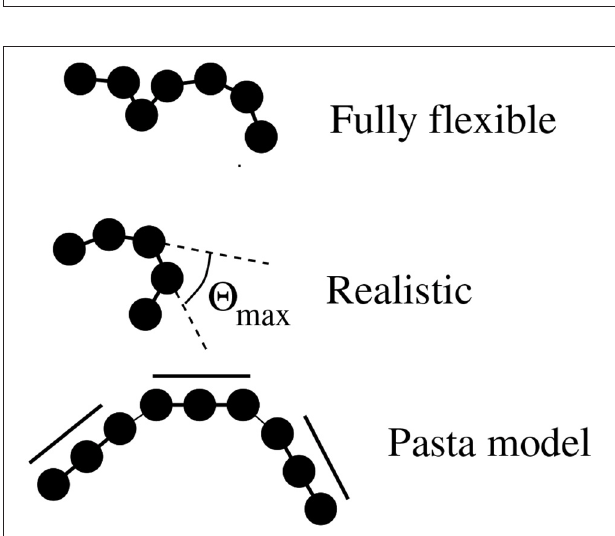
FIGURE 4 | The various simulated chains with differing internal stiffness interactions. The chain used in the experiments has 2 max